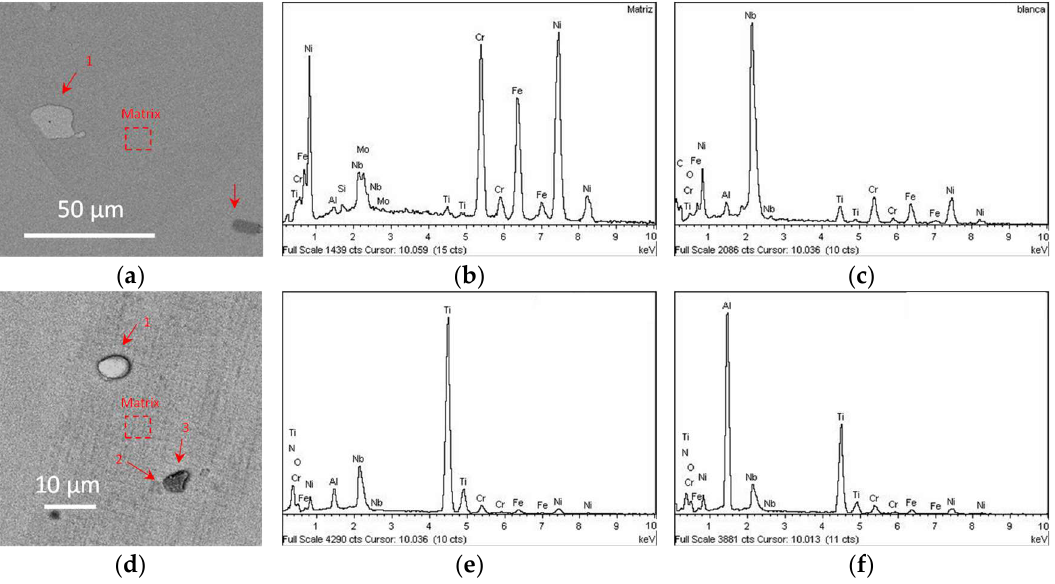
Figure 13. Substrate SEM analysis: ( a ) Homogenized sample; ( d ) STA sample; ( b ) matrix EDS; ( c ) white particle EDS; ( e ) Grey particle EDS; ( f ) Black particle EDS.